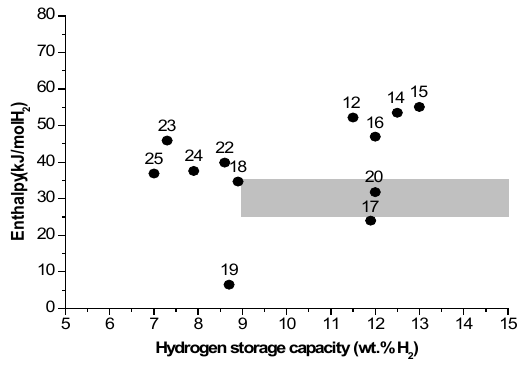
Figure 5. The reaction enthalpy (calculated by DFT without zero- point energy correction [36]) at 300 K per 1 mol H (12-25) reactions versus theoretical hydrogen storage capacity. Gray rectangular squares describe fuel cell